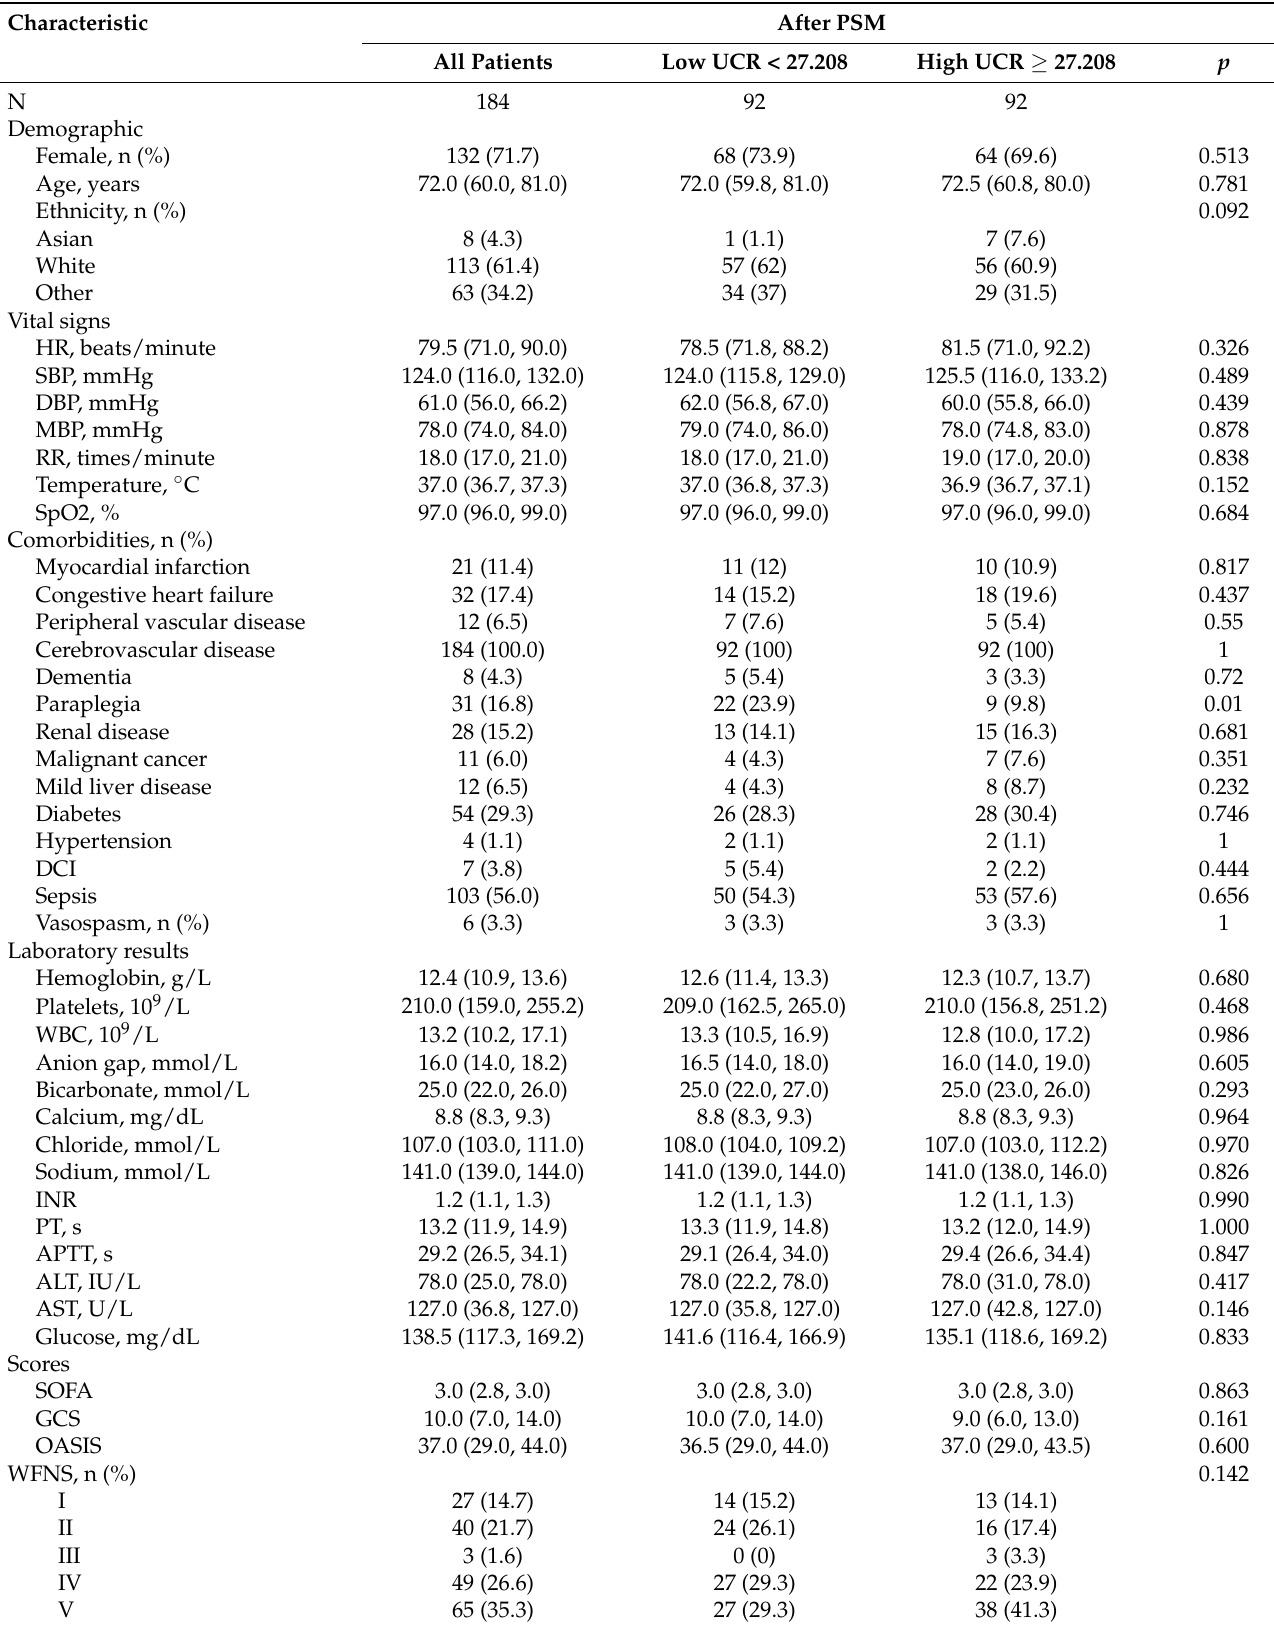
Table 4. The clinical characteristics of non-traumatic subarachnoid hemorrhage after